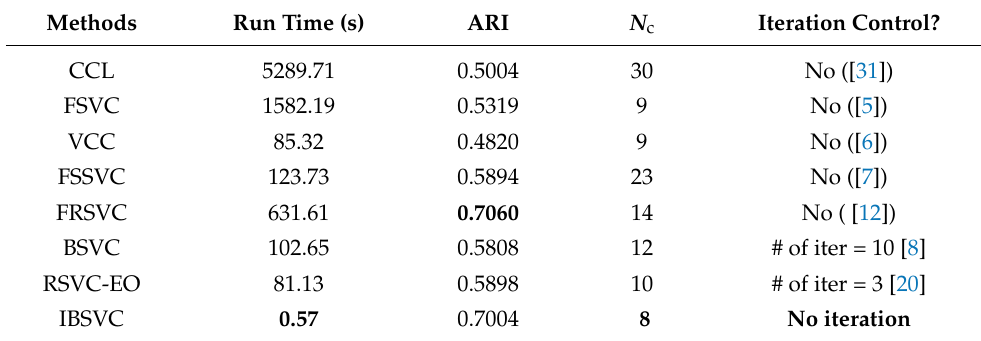
Table 3. q exploration with 10 rounds of analyses on